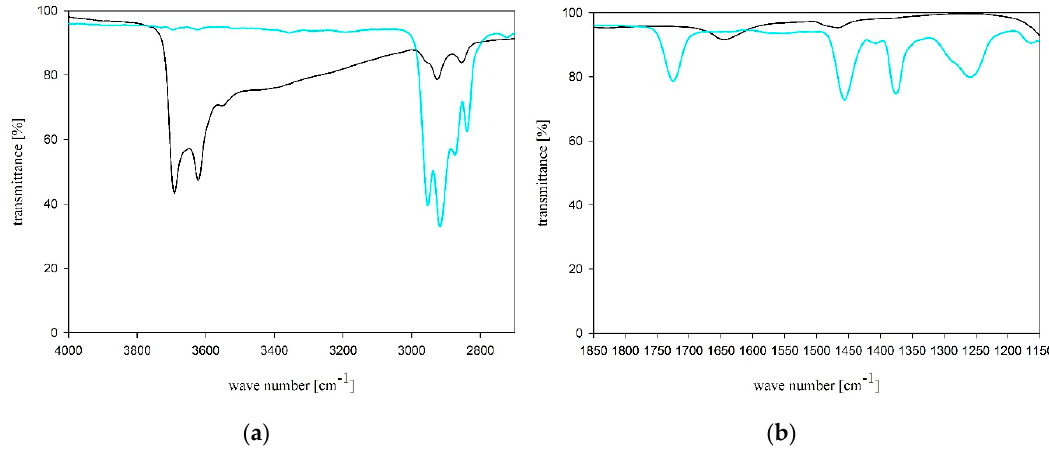
Figure 3. FTIR (ATR) spectra of BH (black line) and MFM nonwoven (blue line); ( a ) wave number range between 4000 and 2700 cm − 1 , and ( b ) between 1850 and 1150 cm − 1 .